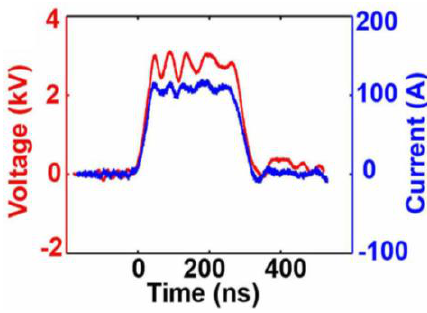
Figure 2. Typical voltage (red) and current (blue) pulse generated across a tumor with a 300ns pulse (reprint with permission from Elsevier